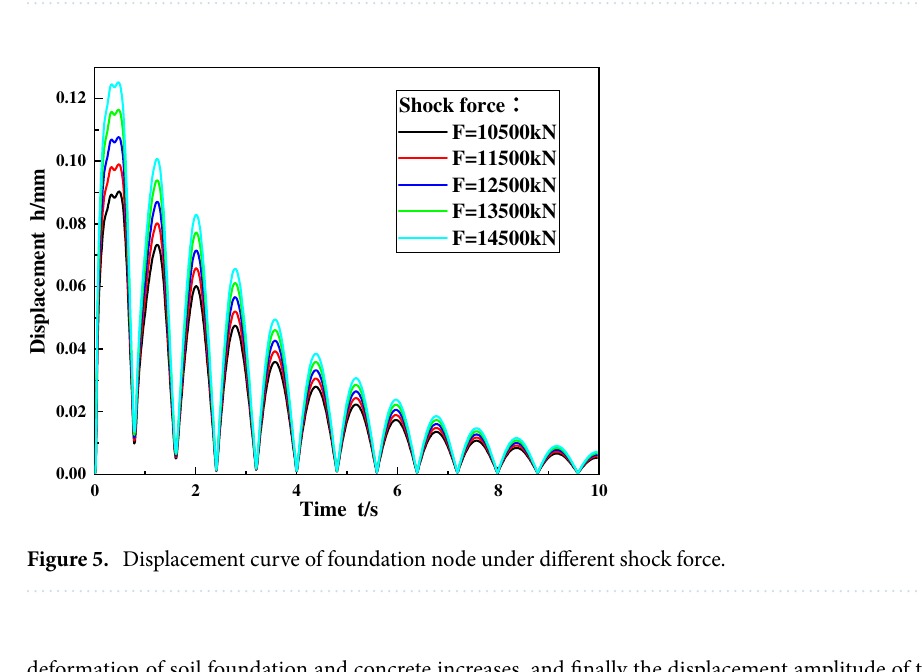
Figure 4. Displacement curve of foundation node at discharge position.